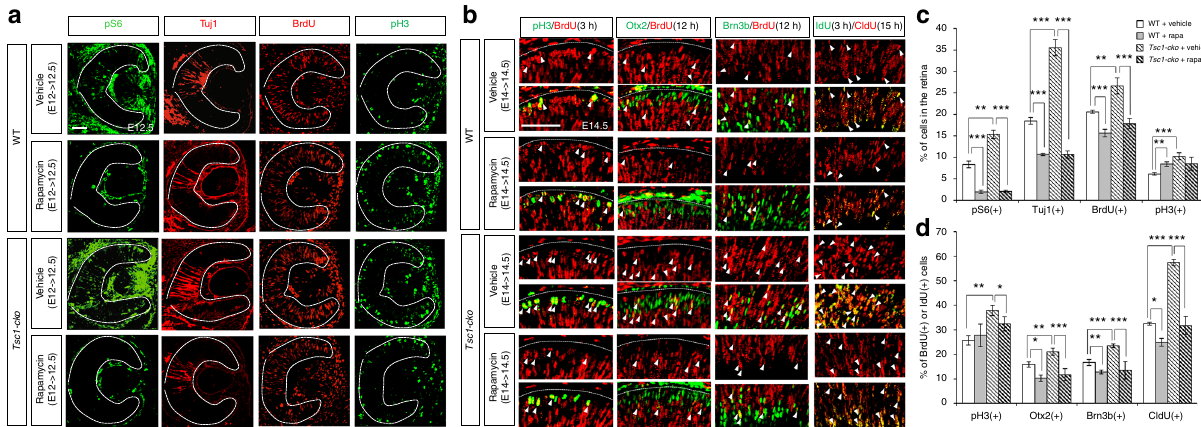
Fig. 3 mTORC1 inhibition by rapamycin inhibits RPC cell cycle and retinal development. a Pregnant mice were injected with vehicle (see Methods) or rapamycin (5 mg/kg) into the peritoneum at 12 dpc, and the embryos were collected at 12.5 dpc (E12.5). BrdU were injected at 3 h prior to the embryo collection. Distribution of each marker in the embryonic retinas was investigated by immunostaining with corresponding antibodies. Dotted lines mark retinal margins. Scale bar, 100 μ m. b Cell cycle progression of embryonic RPCs in the rapamycin-injected mice was examined as described in Fig. 2f. Scale bar, 100 μ m. c Percentages of cells expressing the markers in a are shown in a graph. Values are averages ( n = 5 from 3 independent litters) and error bars denote SD. d Ratios of BrdU-co-expressing cells to total marker-expressing cells are shown in a graph ( n = 5 from 3 independent litters). Error bars denote SD. P -values are obtained by one-way ANOVA test and shown in the graphs (*<0.05; **<0.01;